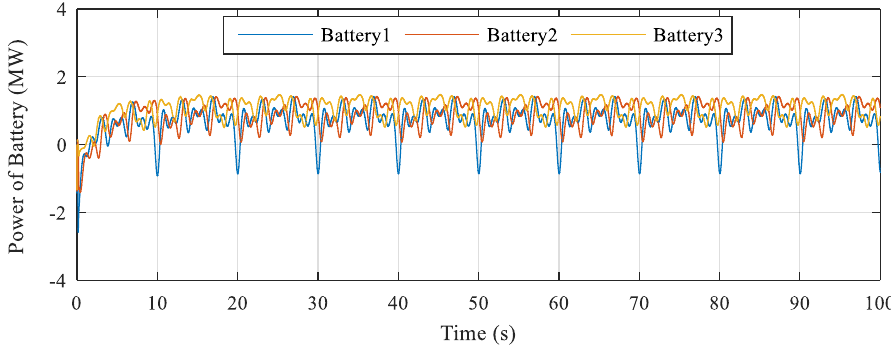
Figure 17. Power of battery without proposed controller (Case 2).